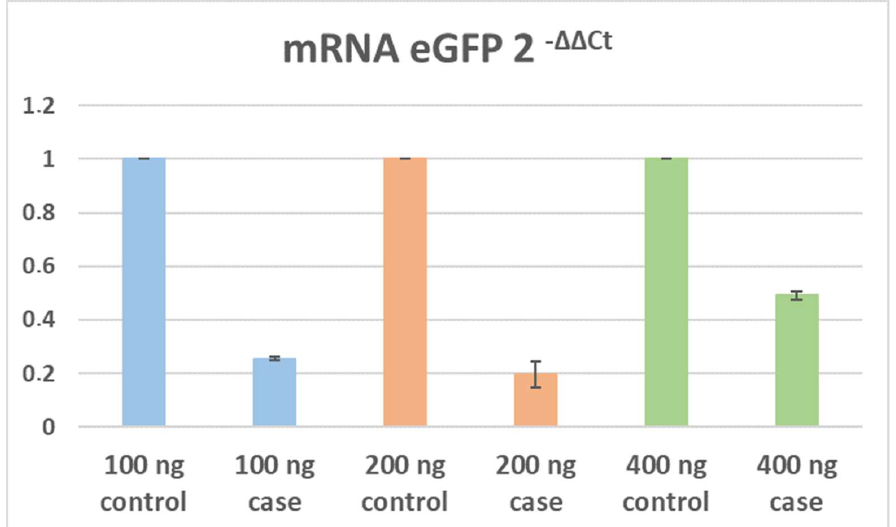
Figure 4. Normalised data for the relative expression of eGFP mRNA obtained by qRT-PCR; repre- sentative data for n = 3. The values for the transfection of the 100 ng case condition compared to the 100 ng control condition are represented in blue; the values for the transfection of the 200 ng case condition compared to the 200 ng control condition are represented in orange; and the values for the transfection of the 400 ng case condition compared to the 400 ng control condition are repre- sented in green. The standard media error is also shown.